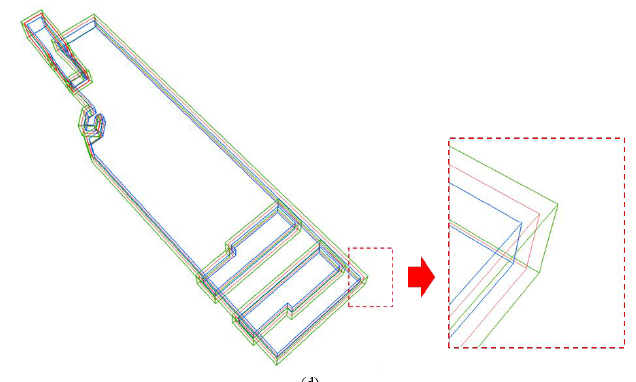
Figure 10. Iso metric view of 3D underground cadastral map in Gangnam subway station: ( a ) 3D underground construction parcel boundary of 1st underground floor: Gangnam underground shopping mall; ( b ) 3D underground construction parcel boundary of 2nd underground floor: subway station platform; ( c ) 3D underground construction parcel boundary of Gangnam subway station with highlight on particular underground parcels; and ( d ) 3D underground internal boundary (blue), 3D underground construction parcel boundary (red), and 3D underground legal space parcel boundary (green).